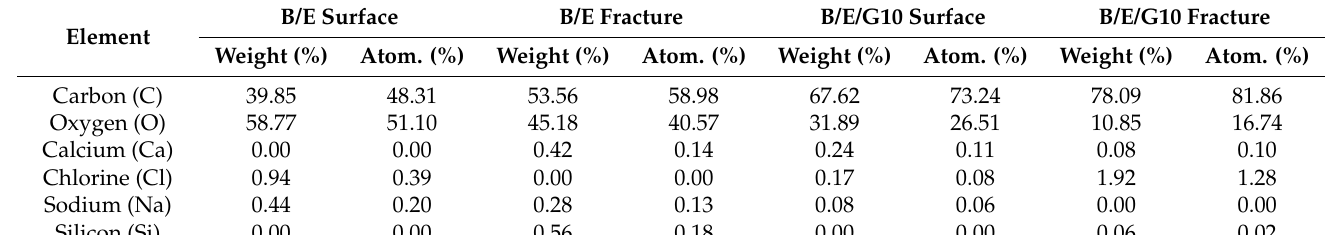
Table 3. The chemical composition of basalt and E-glass hybrid composites at surface and fracture position. Figure 11. SEM images for map data of hybrid composites ( a ) B/E at surface, ( b ) B/E/G10 at surface, ( c ) B/E at fracture and ( d ) B/E/G10 at fracture.